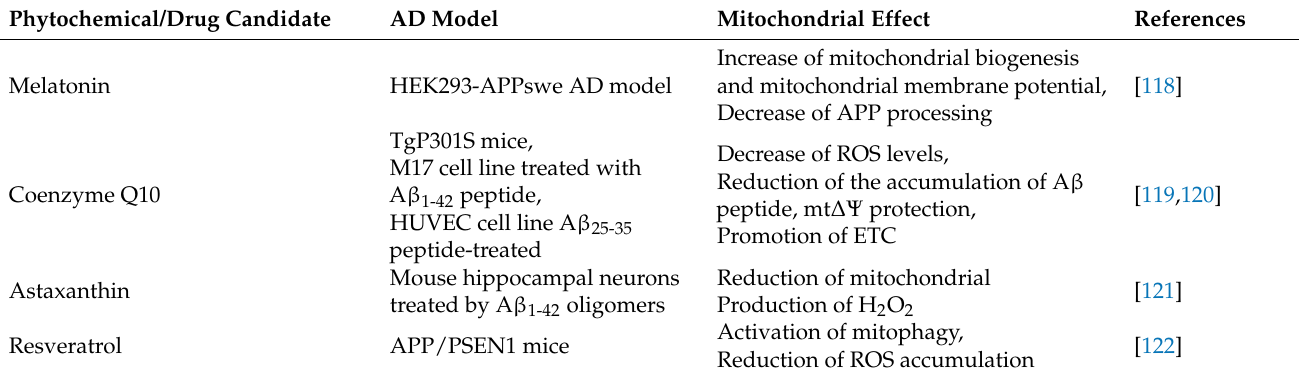
Table 2. Phytochemicals and other chemicals used for mitochondrial-targeted therapies in AD models in preclinical and clinical